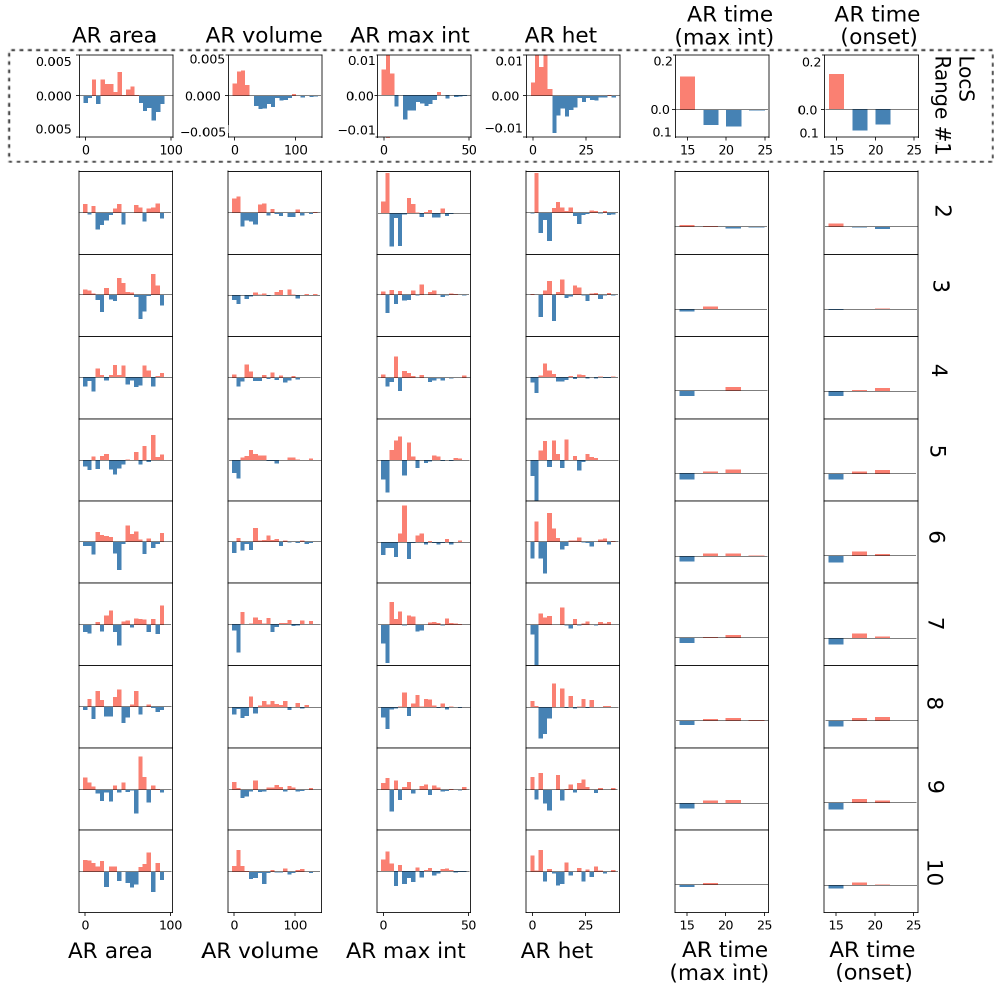
Figure 3. Preference of each rain property over antecedent soil moisture heterogeneity conditions. As in Figure 2, the histogram difference between two probability density functions is shown: one histogram corresponding to the sample of that particular AR property in the particular LocS range; the second one resulting from the total sample of that AR property independent of the LocS range. Unlike in Figure 2, the values of the rain properties are separated into bins and shown in actual units (from left to right): rain area (%), volume (mm/9 h), maximum intensity (mm/h), spatial heterogeneity (mm/9 h), time of maximum intensity (LST) and onset time